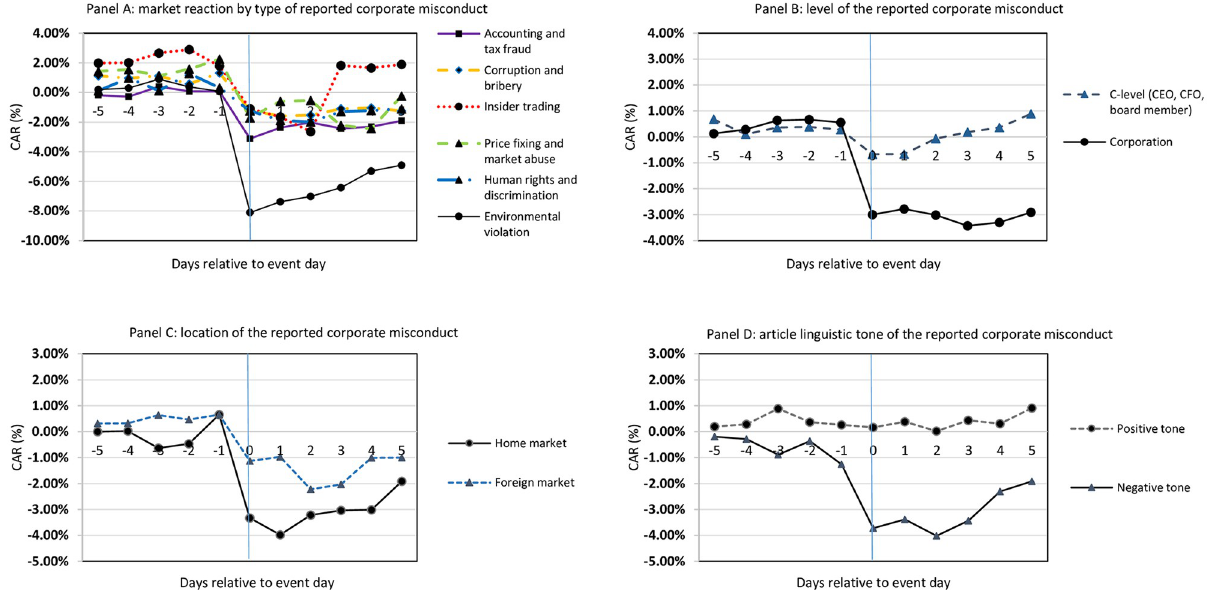
Fig 1. Market reaction around the reported corporate misconduct events. Notes : Panel A, panel B, panel C, and panel D of Fig 1 graphically show the results presented in Table 1.